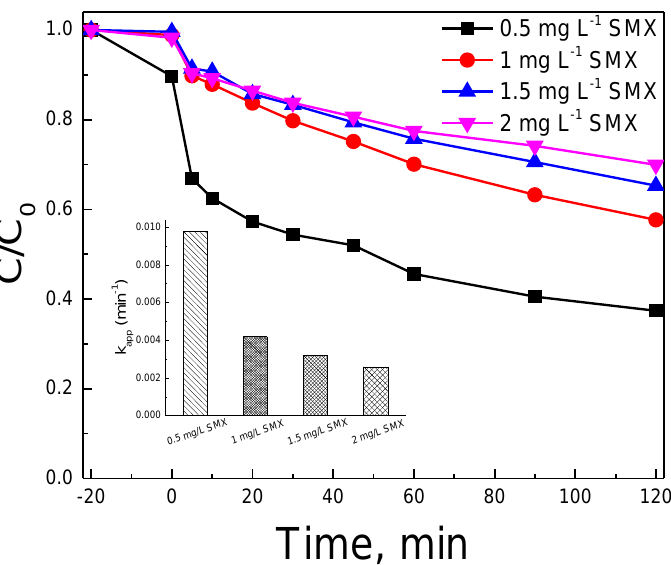
Figure 5. Effect of initial SMX concentration on its degradation with 500 mgL − 1 RHB700 and 500 mgL − 1 SPS in UPW and inherent pH. Inset graph shows the corresponding k app values.